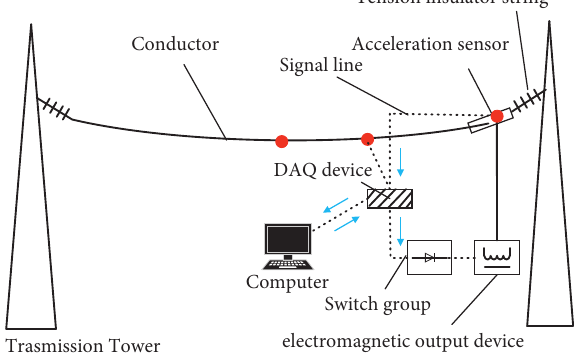
Figure 10: Galloping excitation system schematic